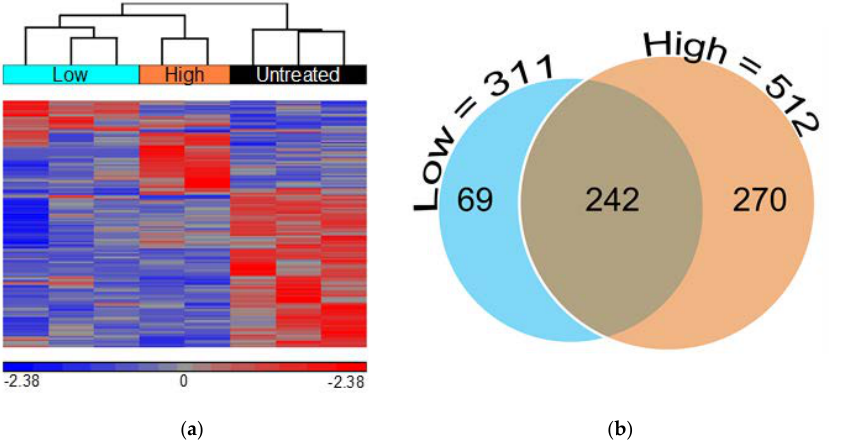
Figure 1. Low and high doses of GGF2 alter intercostal skeletal muscle transcription. ( a ) Hierarchical clustering of 581 genes significantly differentially expressed between GGF2-treated and untreated post-MI swine. Columns represent individual samples for each group, and rows represent individual probes/genes. Red, blue, and gray represent the highest, lowest, and medial fluorescent signal values, respectively. ( b ) Venn diagram showing numbers of genes differentially expressed in post-MI swine treated with GGF2 at low (teal circle, 311 genes) and high doses (orange circle, 512 genes) compared to untreated control